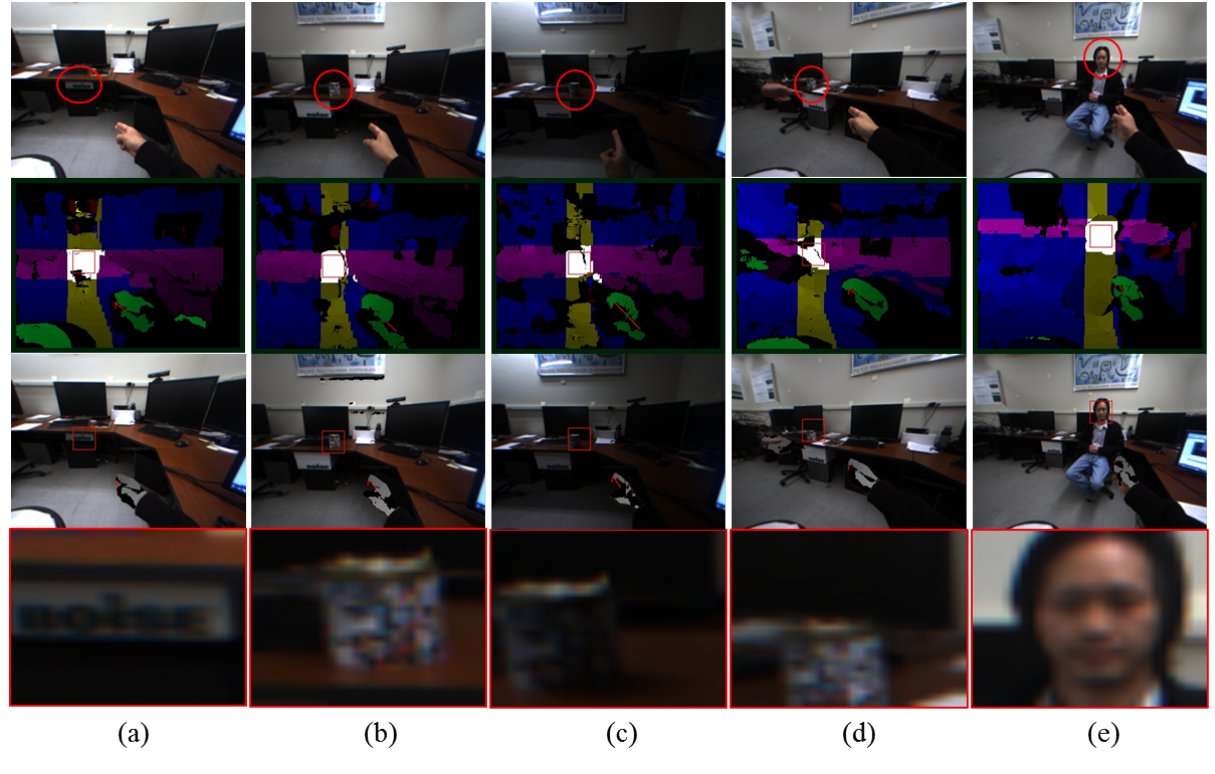
Figure 14. Results with varying illumination conditions and occlusions: ( a – c ) three lighting conditions (bright, normal, dark) and ( d , e ) occlusions by other people’s hand and